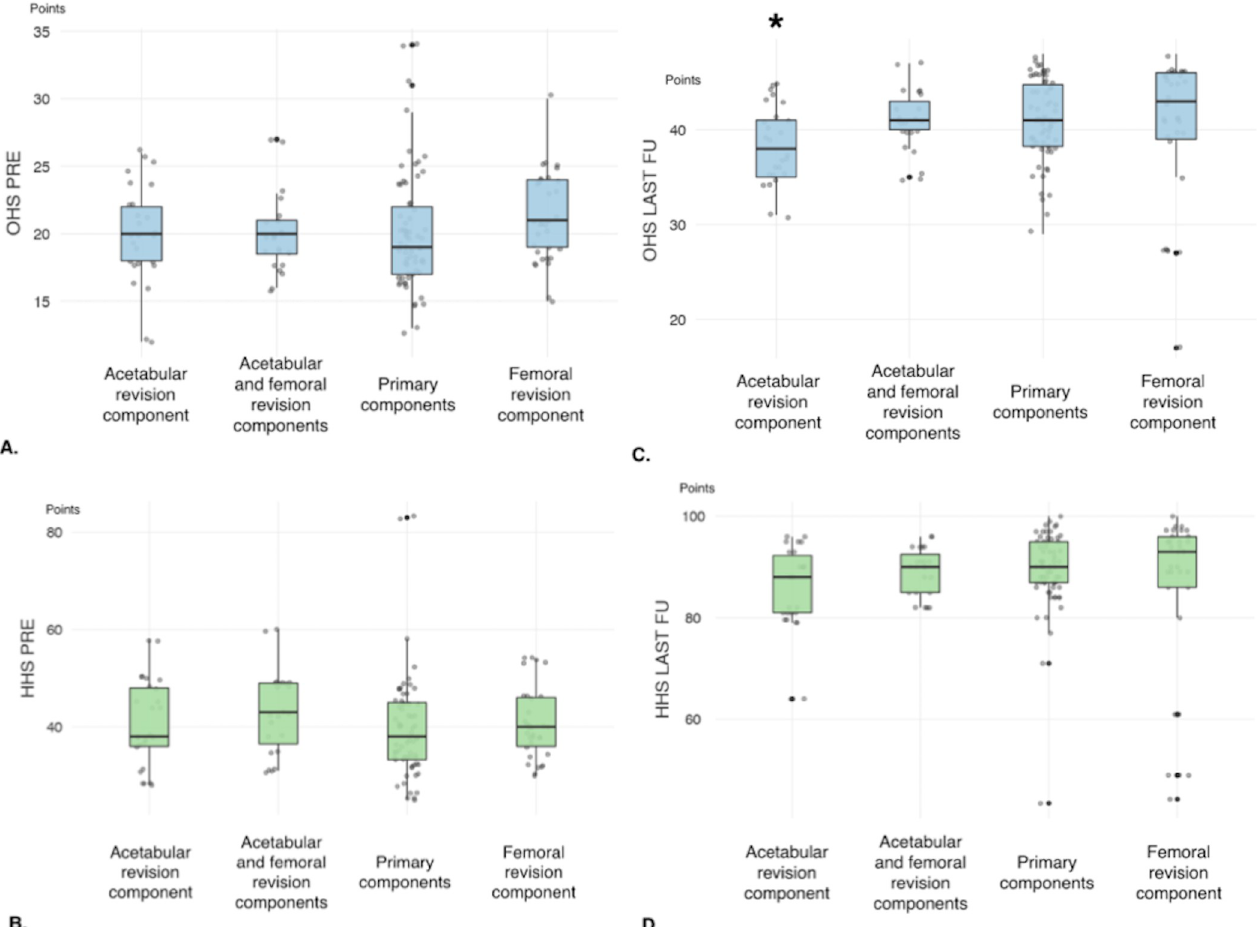
Fig 2. Graph presentation of clinical scores. Pre-operative OHS (A), HHS (B) and final values of OHS (C) and HHS (D) within groups of patients sub-divided by type of component used in the second stage procedure. Asterisks highlight the significant data that were identified by the analysis of variance (ANOVA) and post hoc